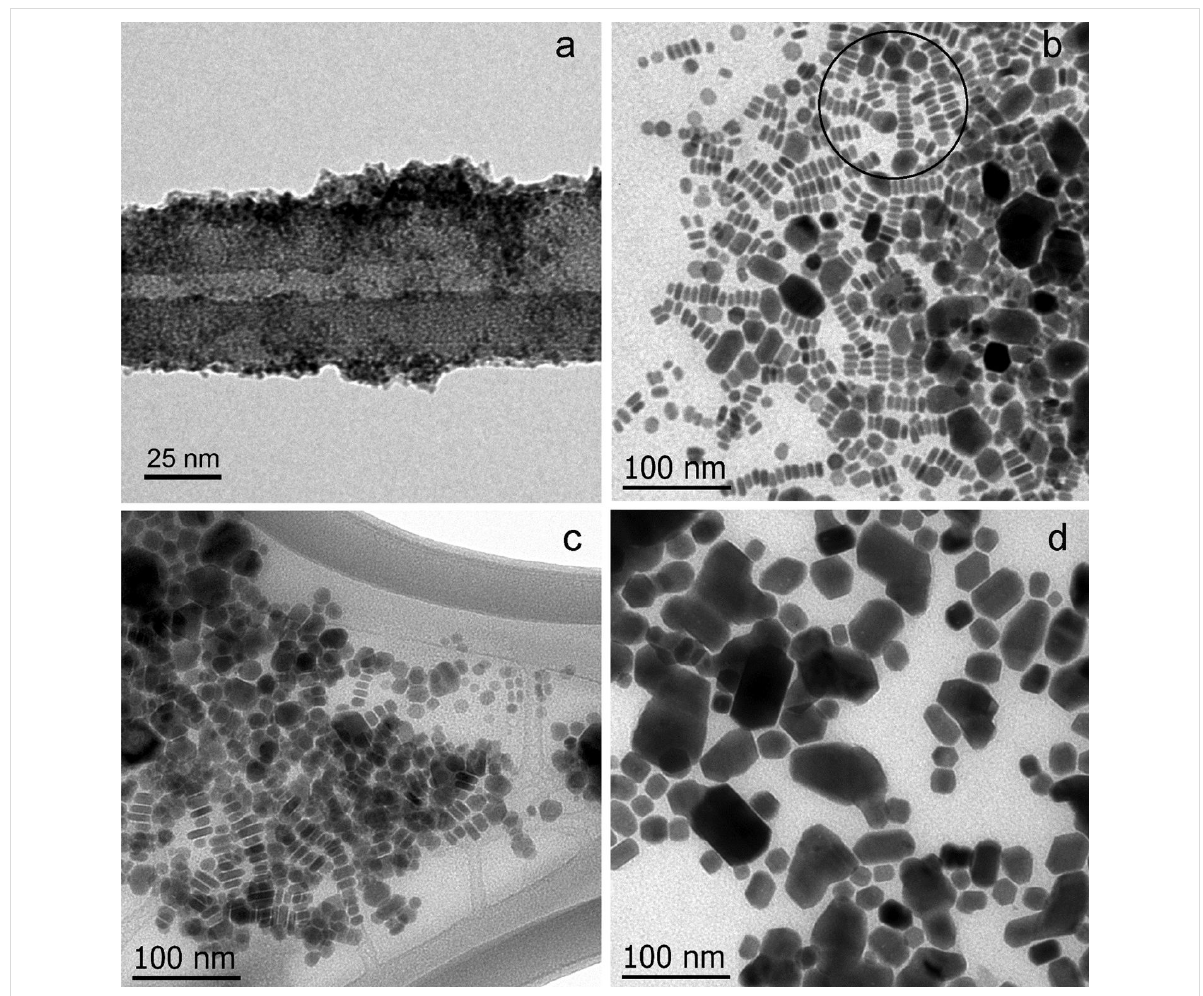
Figure 2: TEM images of copper sulfide synthesized in organic solution at a) 220, b) 230, c) 240 and d) 260 °C. The morphology of the Cu x S change from irregular nanoparticles to nanoprisms with increasing temperature. The encircled area shows an alignment of the nanorrods (b).